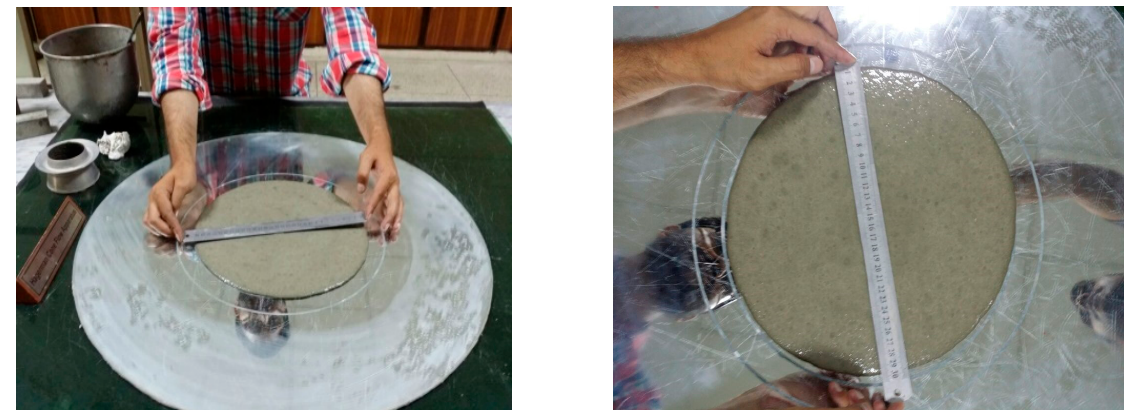
Figure 9. Flow test of self-compacting cementitious mortar.